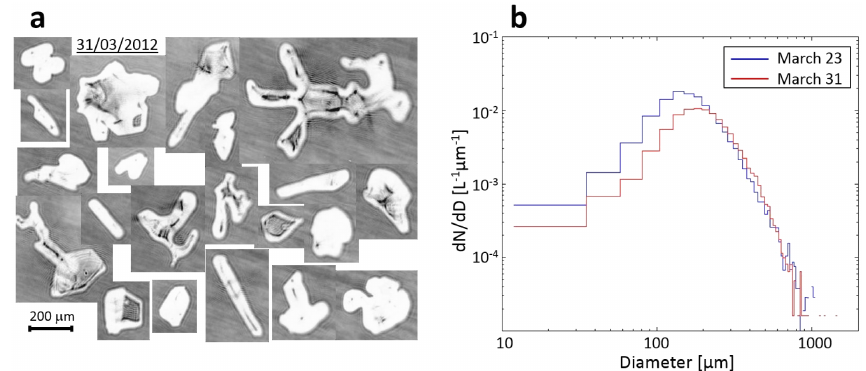
Figure 2. (a) Examples of snow grains imaged by the CPI instrument on 31 March 2012 and (b) size distributions for both the 23 and 31 March